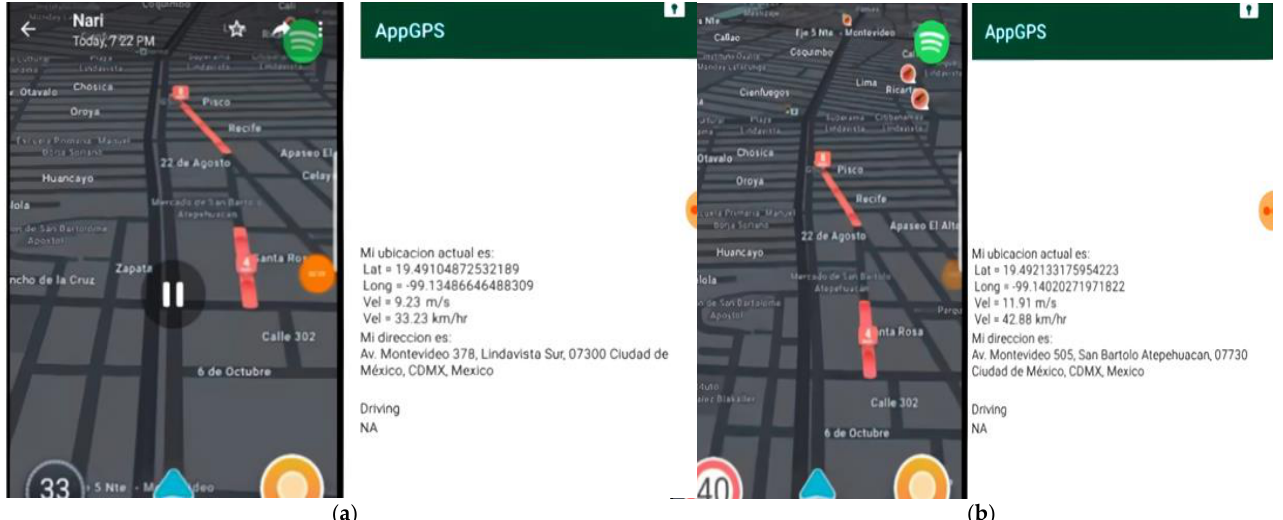
Figure 6. Speed comparison: ( a ) first trip; ( b ) second trip.